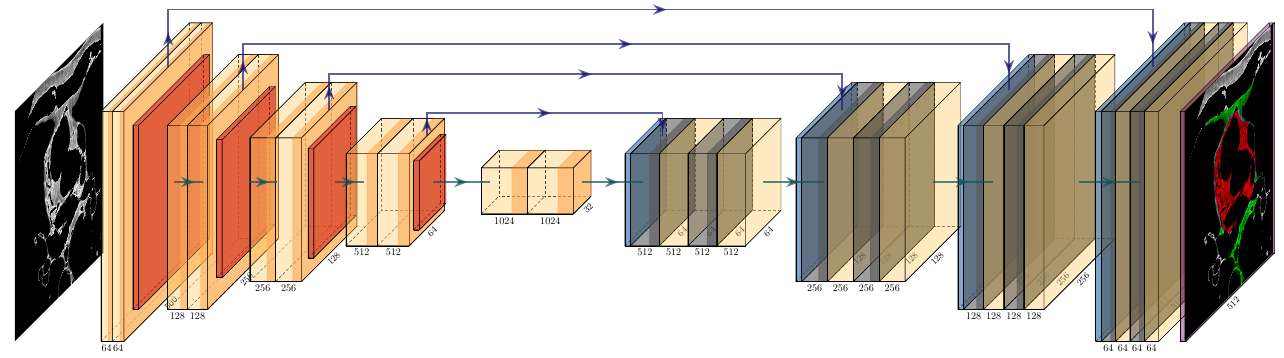
Figure 8. A diagram of the U-Net CNN architecture [35]. The left side of the diagram shows the contracting path, while the right side of the diagram shows the expanding path. The blue arrows represent crop and concatenation operations, while the gray arrows represent convolutional and pooling operations. In the final prediction, the red area is EAT while the green area is paracardial adipose